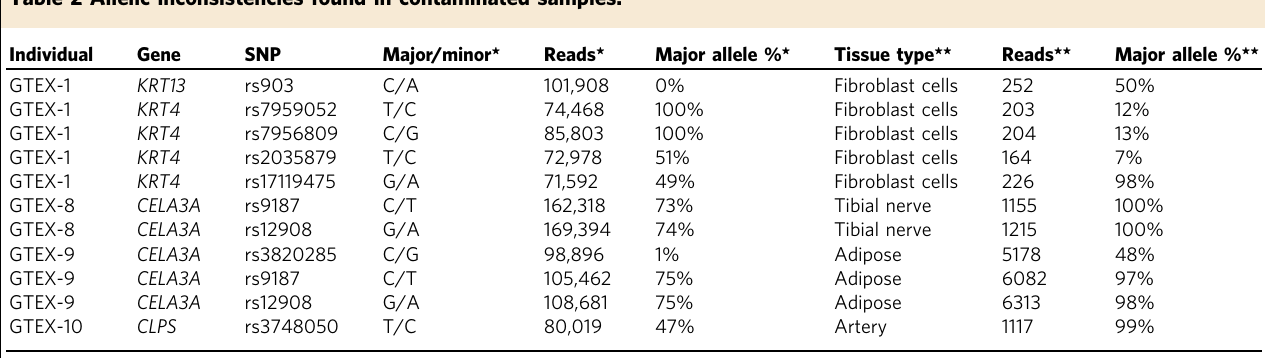
Table 2 Allelic inconsistencies found in contaminated